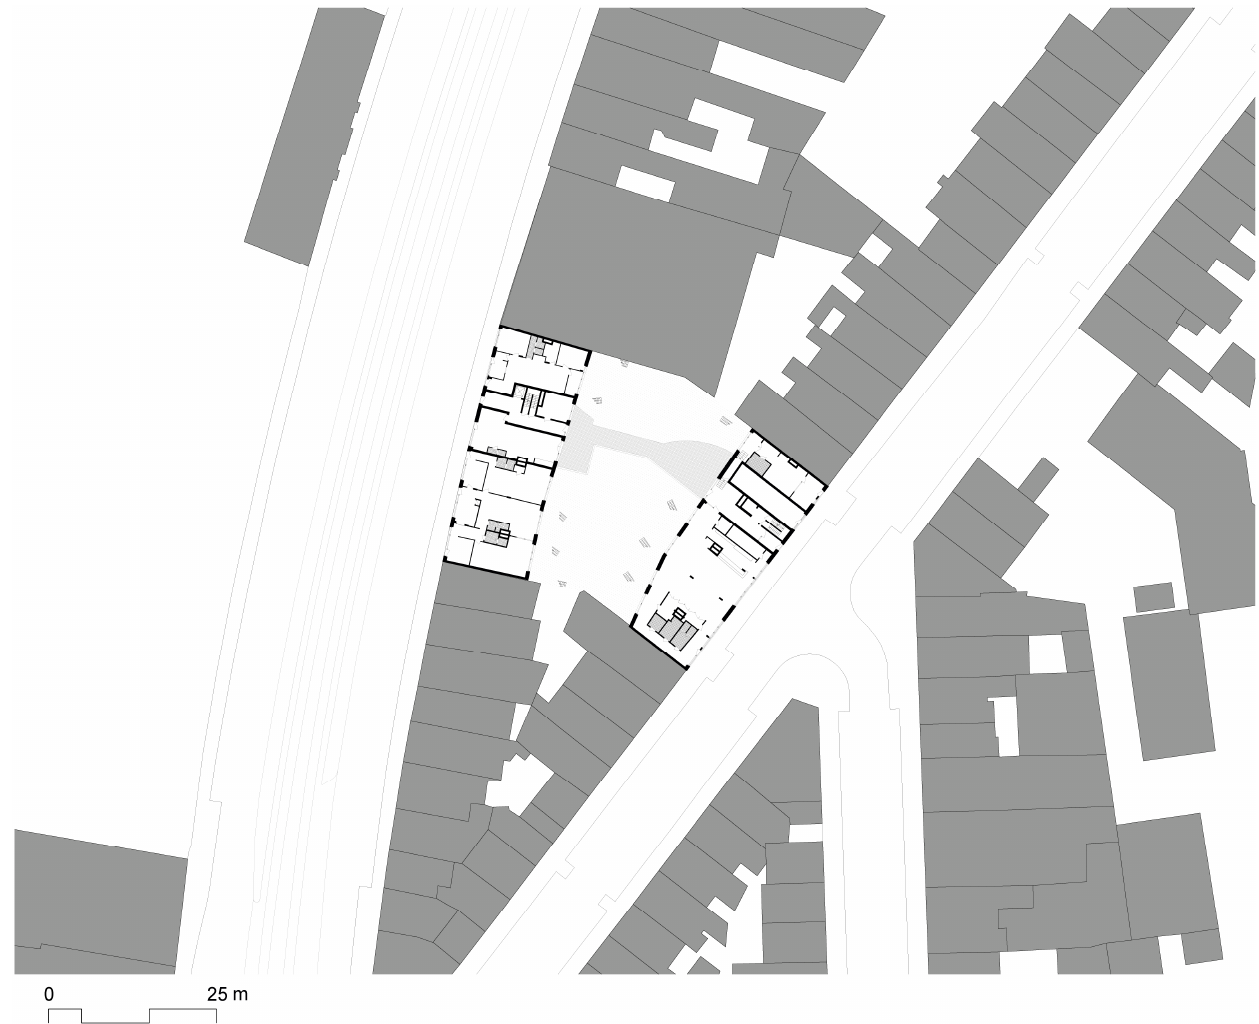
Figure 11. Urban layout of the project “Brutopia” by Stekke + Fraas architects (re-drawing by the authors). A typological mix combines duplex apartments distributed according to a circulation gallery and single apartments that are accessible by the stairwell. Positioned on the street sides, the two-meter-wide gallery allows duplex apartments to be oriented towards the central garden (Figure 12). Despite their variety, the apartment layouts remain mostly conventional, displaying a traditional day–night division. However, daily spaces—in par- ticular an open, large, and well-lit kitchen—are proportionally bigger than in traditional dwellings. Conversely, bedrooms are usually designed according to normalized stand- ards, limiting activities other than sleeping.